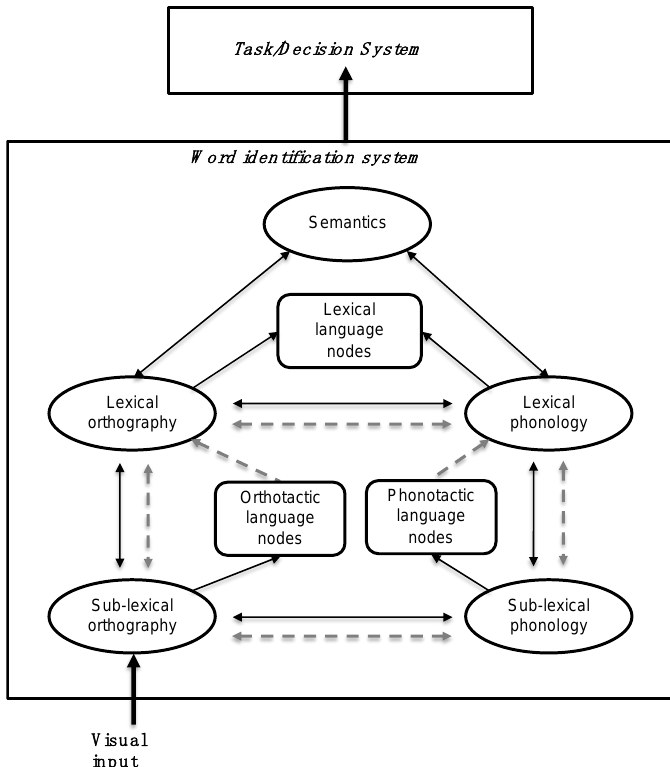
Figure 3. Proposed modification of the Bilingual Interactive Activation + (BIA+) extended model to account for language-selective effects emerging within an integrated lexicon, tentatively labeled BIA+s. We implement the separation of the sub-lexical language node into two different nodes: orthotactic language nodes for the orthographic route to semantics, and phonotactic language node for the phonological route. Each node can receive information from their corresponding sub-lexical units and feed-forward inhibitory links to the lexical orthography (orthotactic language node) or the lexical phonology (phonotactic language node). Dashed lines represent inhibitory